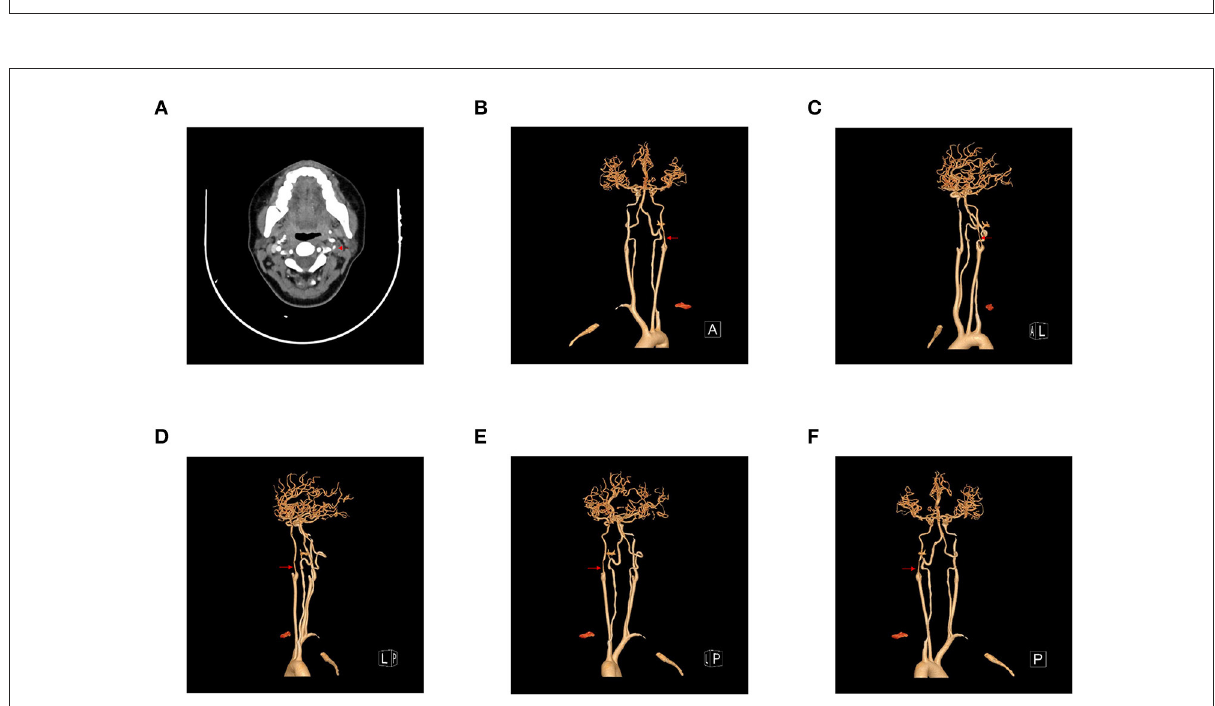
FIGURE2 (A–F) Preoperative head and neck computed tomography angiogram (CTA) and three-dimensional reconstruction of head and neck CTA. Head and neck CTA showed dissection and severe stenosis at the origin of the left internal carotid